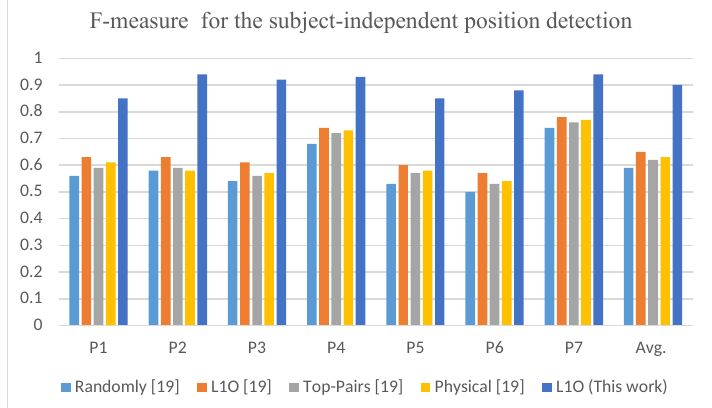
Figure 9. F-measure of subject-independent position detection for this work compared to the work in [19] with different evaluation